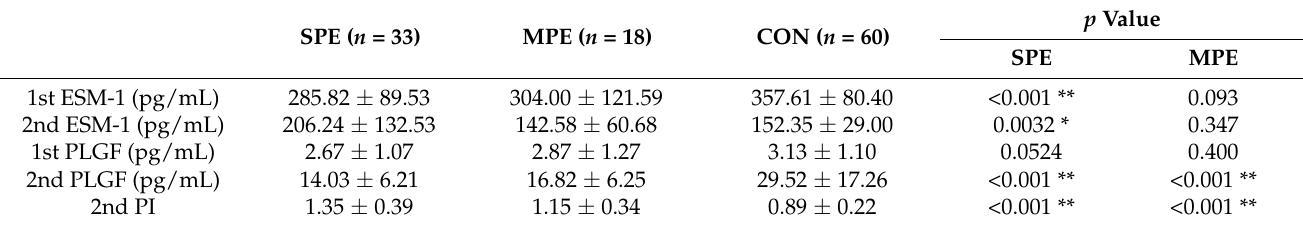
Table 2. Comparison of biomarker levels among study groups.